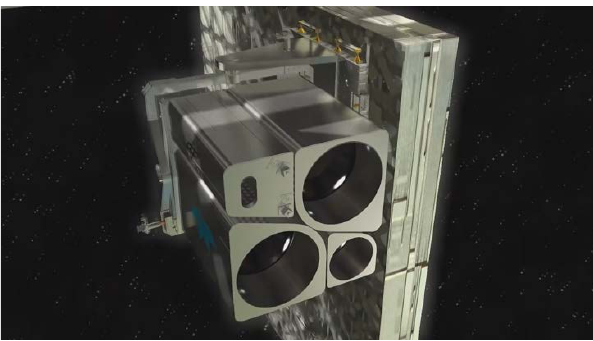
Figure 1 MUSES platform with the four slots for different instruments. The hyperspectral sensor DESIS will be integrated in one of the large slots. (© Teledyne Brown Engineering. All rights reserved.)